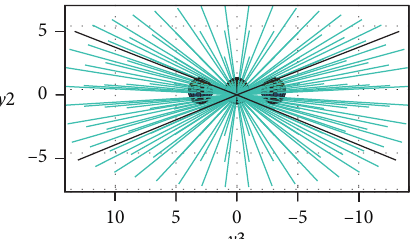
Figure 8: Front projection of the 3D lidar’s view for three obstacles in